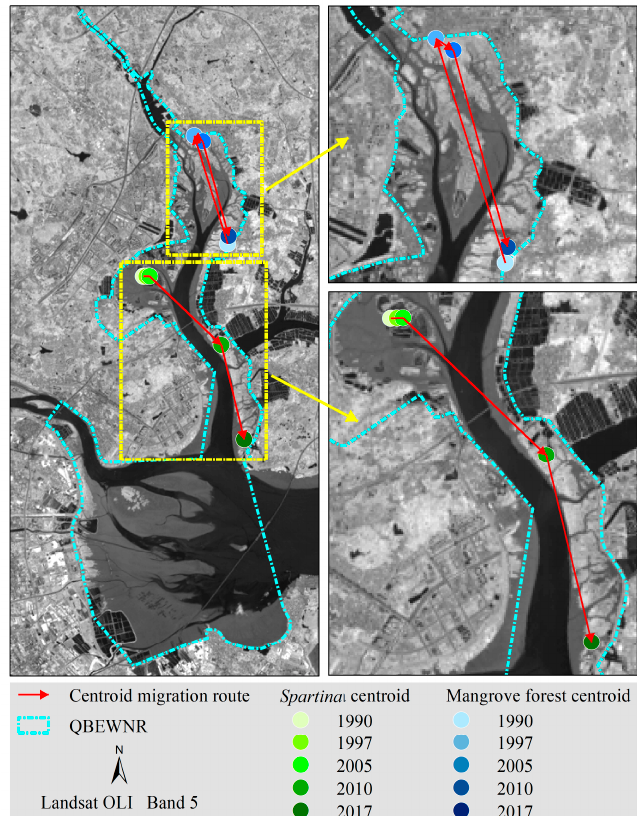
Figure 7. Spatial distribution map of centroid migration for mangrove forests and Spartina from 1990 to 2017.